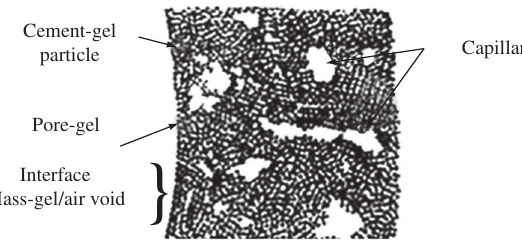
Figure 1. Cement paste structure. Source: Powers e Helmuth 2